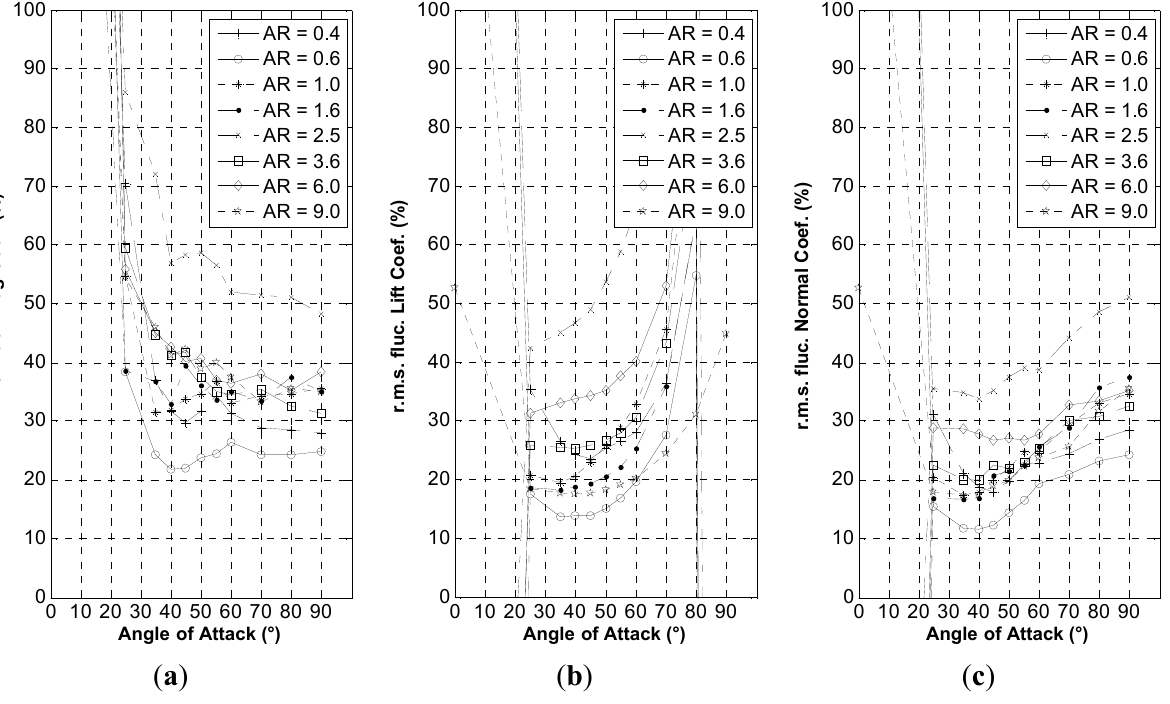
Figure 12. Root mean square fluctuation levels for ( a ) drag; ( b ) lift and ( c ) normal force close to the